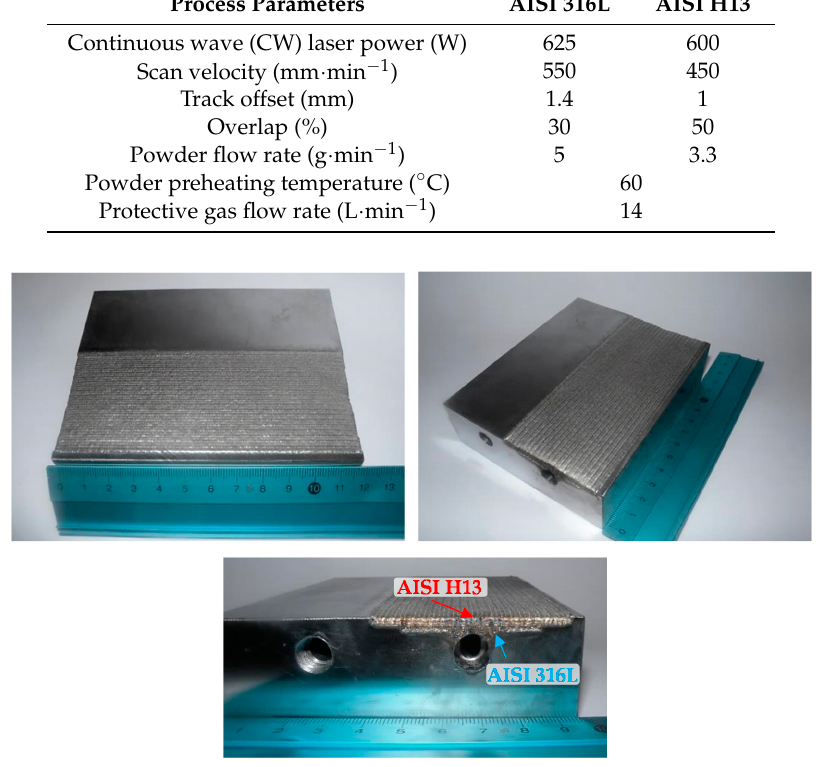
Figure 4. Final part after finishing the LMD process.